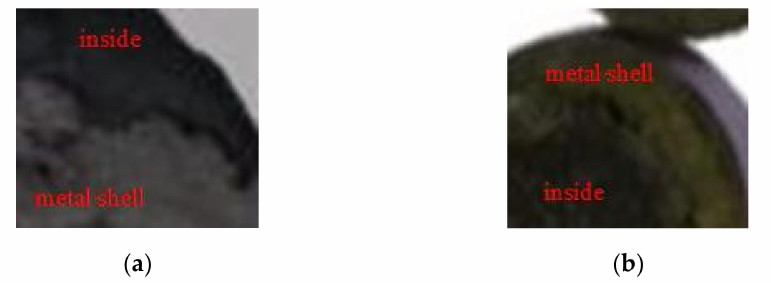
Figure 9. Physical of products at ( a ) 1.2 V and ( b ) 1.6 V ( T = 800 ◦ C, t = 8